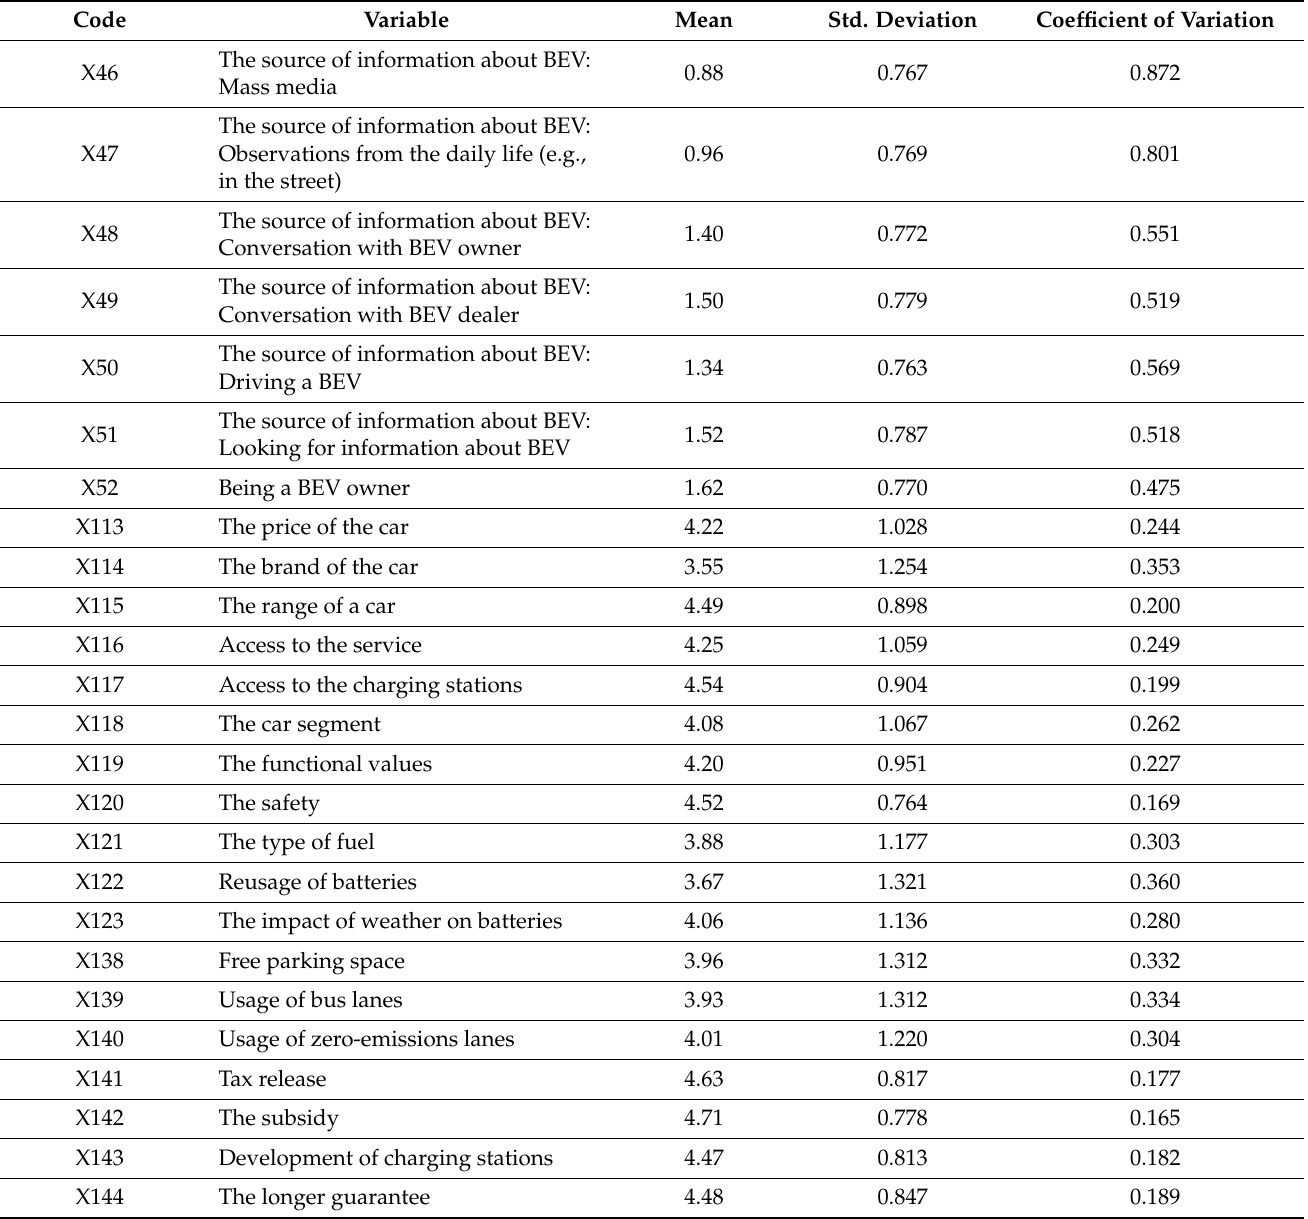
Table 2. Description and basic statistics of